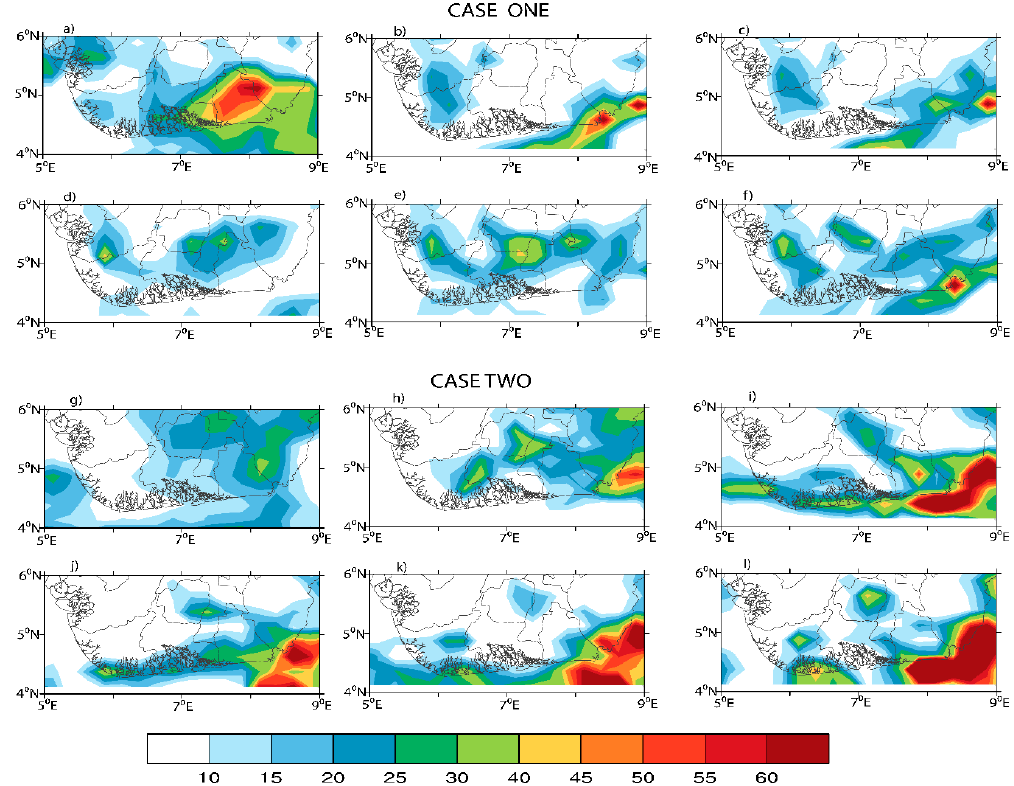
Figure 3. Spatial distributions of 24 h accumulated rainfall in mm over the study area with plot of CASE ONE. ( a ) TRMM data ( b ) MORR_G ( c ) MORR_H ( d ) WDM6 ( e ) WSM6 ( f ) WDM5 and CASE TWO ( g ) TRMM data ( h ) MORR_G ( i ) MORR_H ( j ) WDM6 ( k ) WSM6 and ( l ) WSM5.